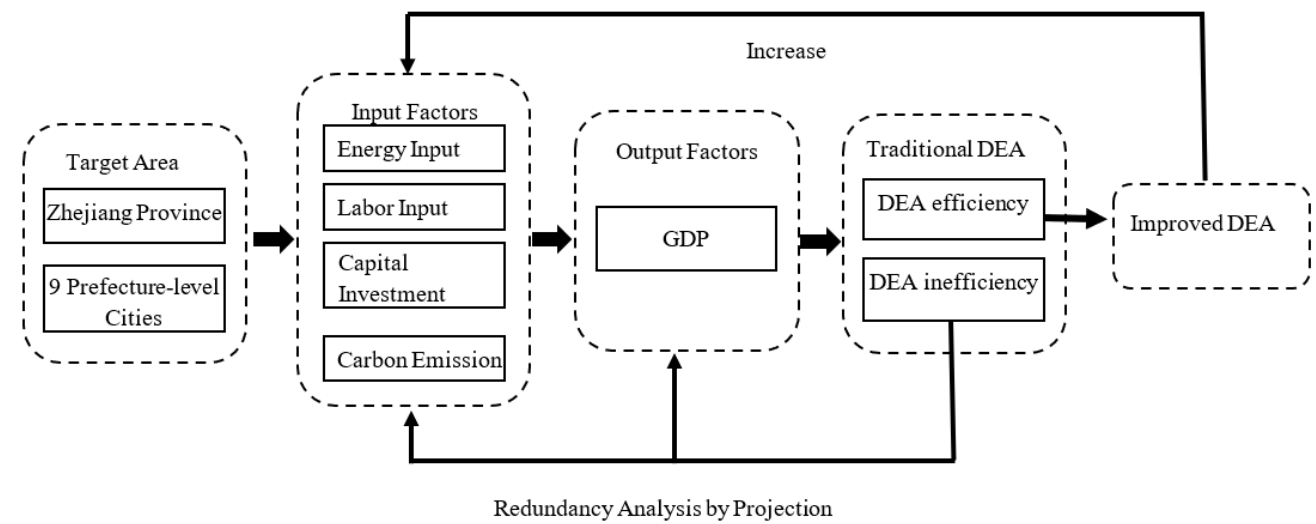
Figure 1. Measurement system of low-carbon economic efficiency in Zhejiang Province.